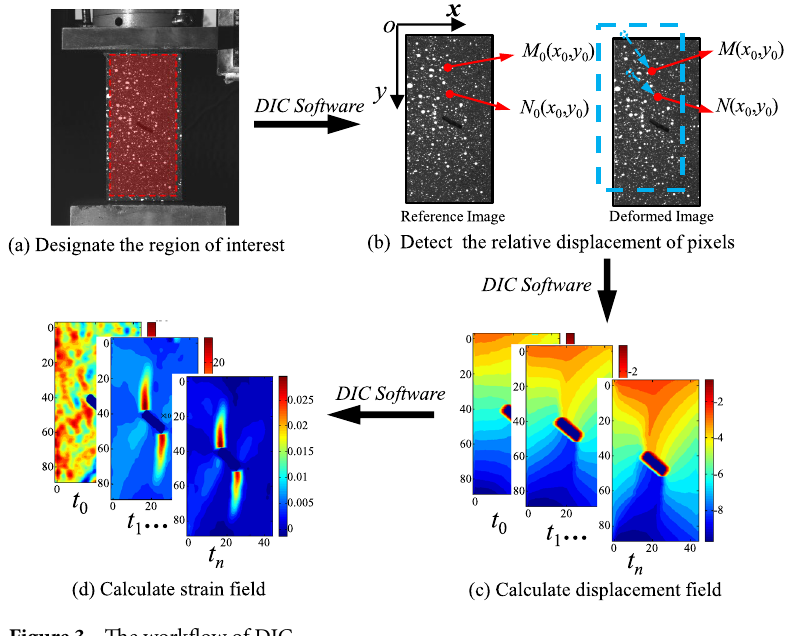
Figure 3. The workflow of